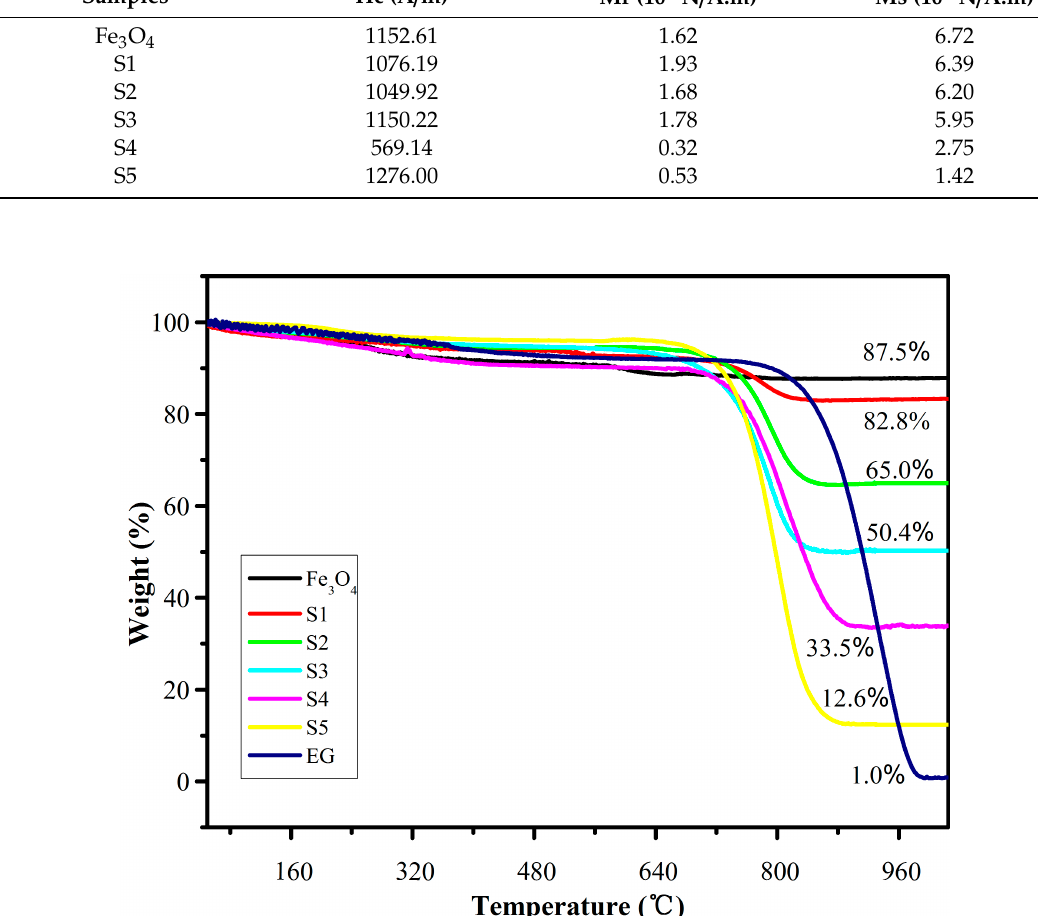
Table 1. Magnetic parameters of Fe 3 O 4 nanoparticles and EG/Fe 3 O 4 composites.